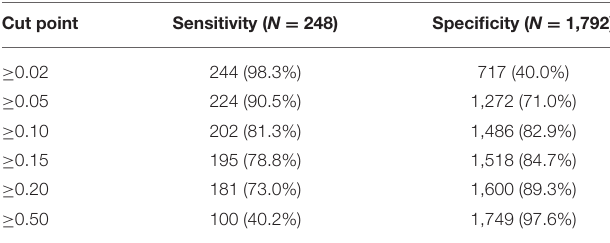
TABLE 4 | Sensitivity and specificity for chosen cut points based on predicted risk from the multiple model with both known and new risk factors included. Cut